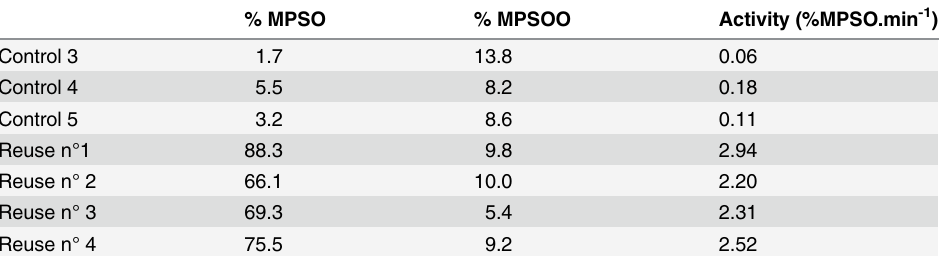
After each reaction beads were washed with DMSO and then water. Percentages of methyl phenyl sulfoxide (MPSO) and methyl phenyl sulfone (MPSOO) were calculated in relation of the initial thioanisole concentration in the liquid phase and measured after 30 minutes of